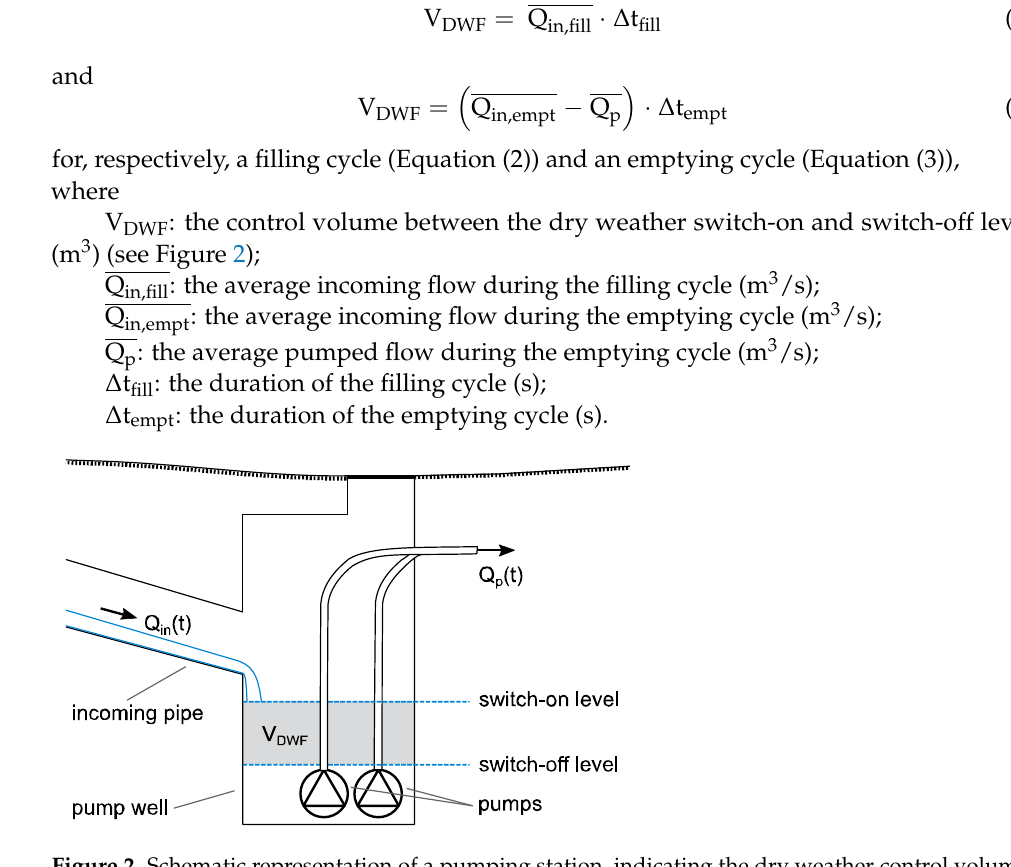
Figure 2. Schematic representation of a pumping station, indicating the dry weather control volume.